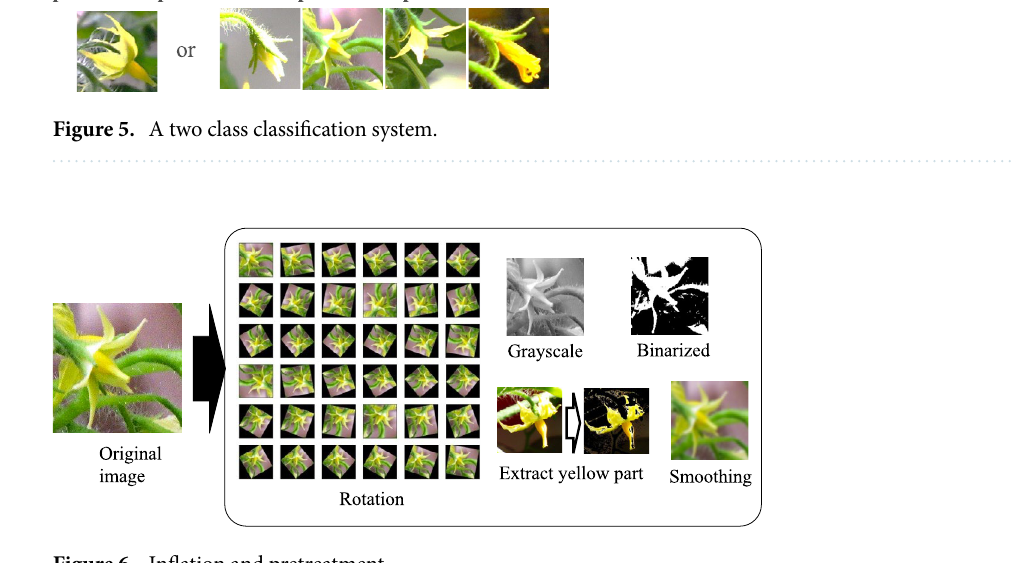
Figure 6. Inflation and